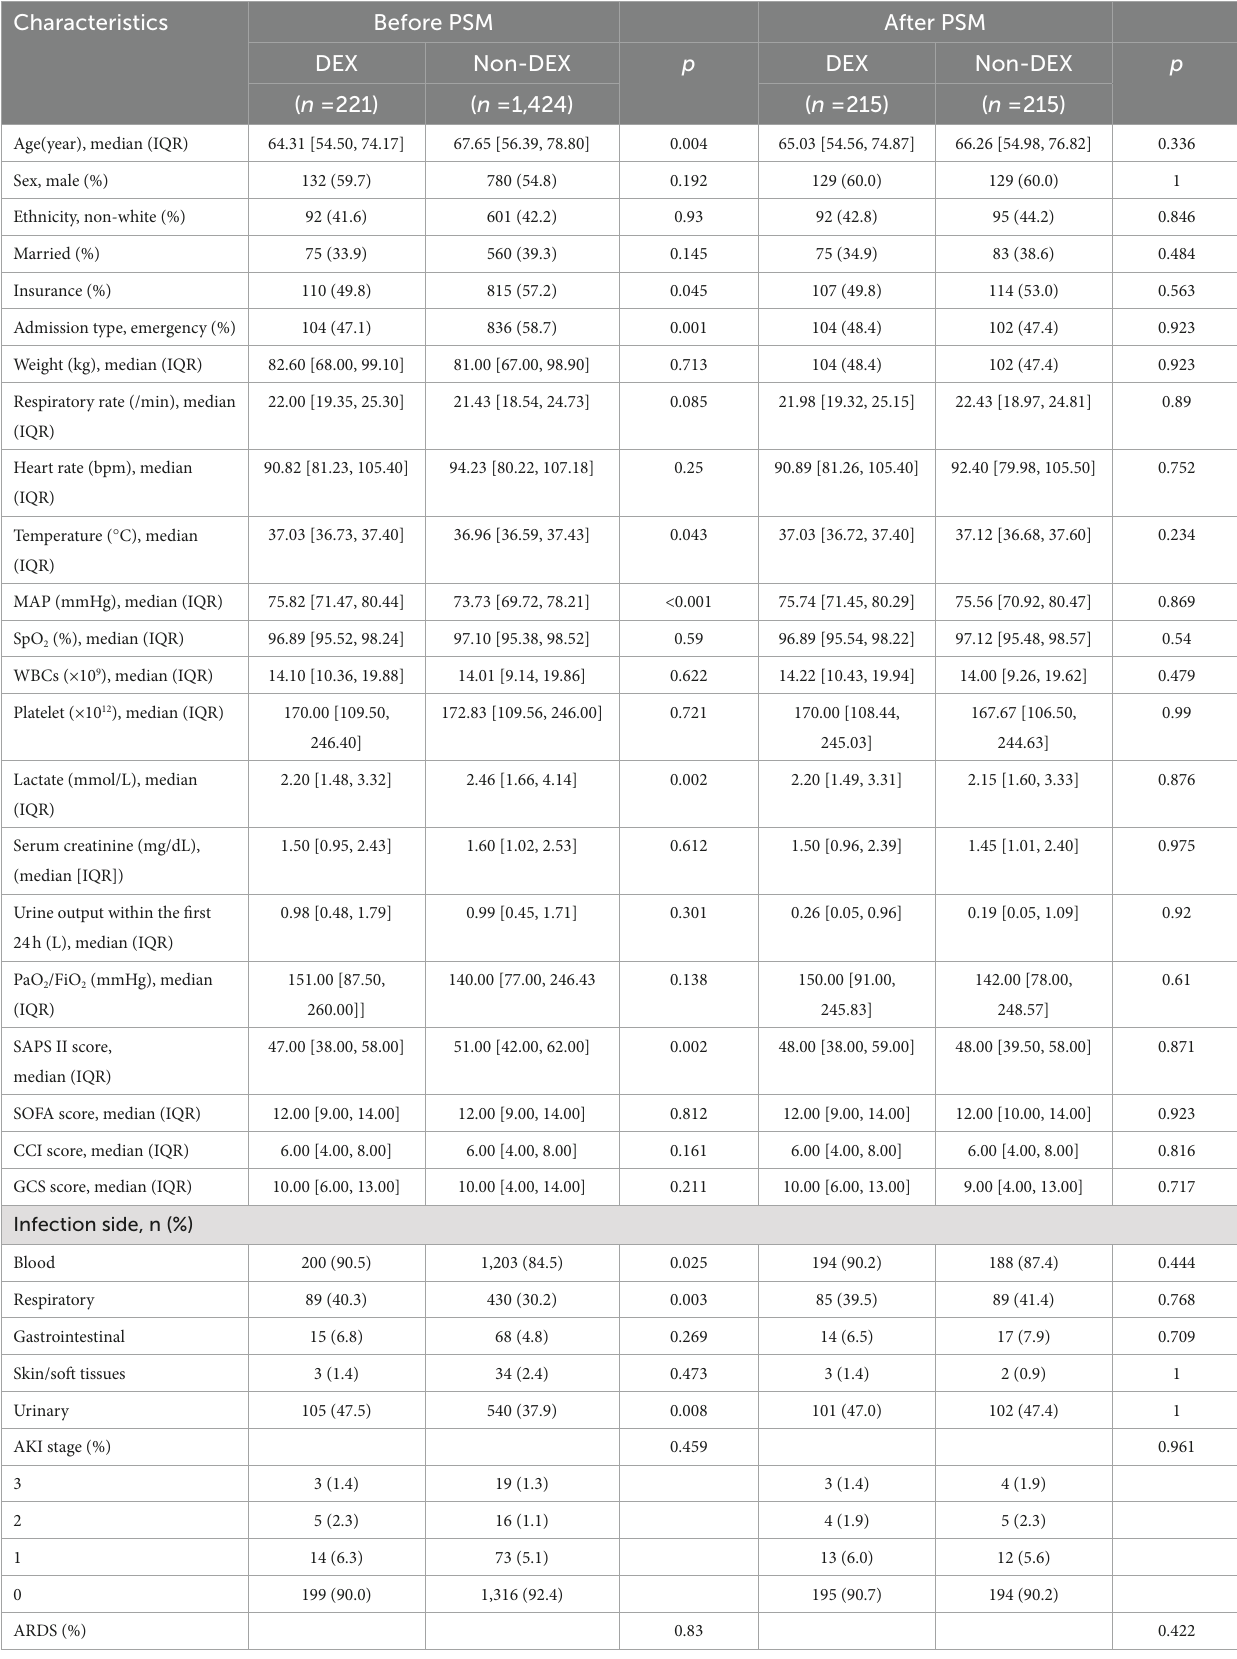
TABLE 1 Baseline characteristics in DEX group and non-DEX group before and after propensity score matching (PSM).